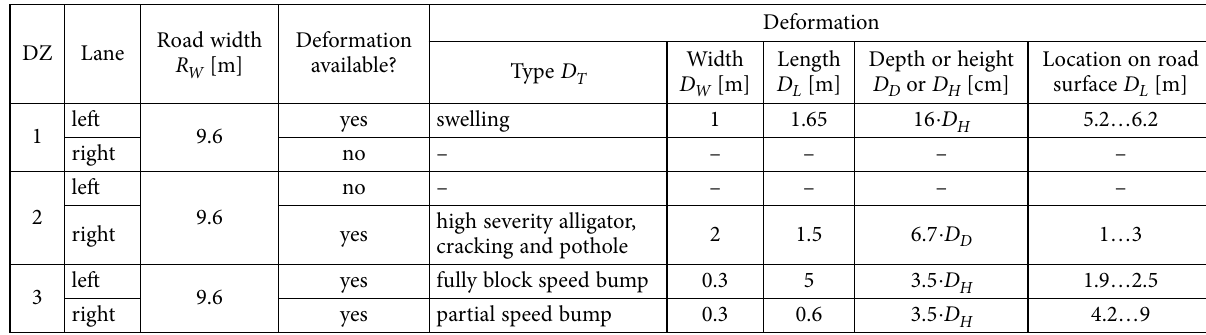
Table 1. DZs and their geometrical and structural properties